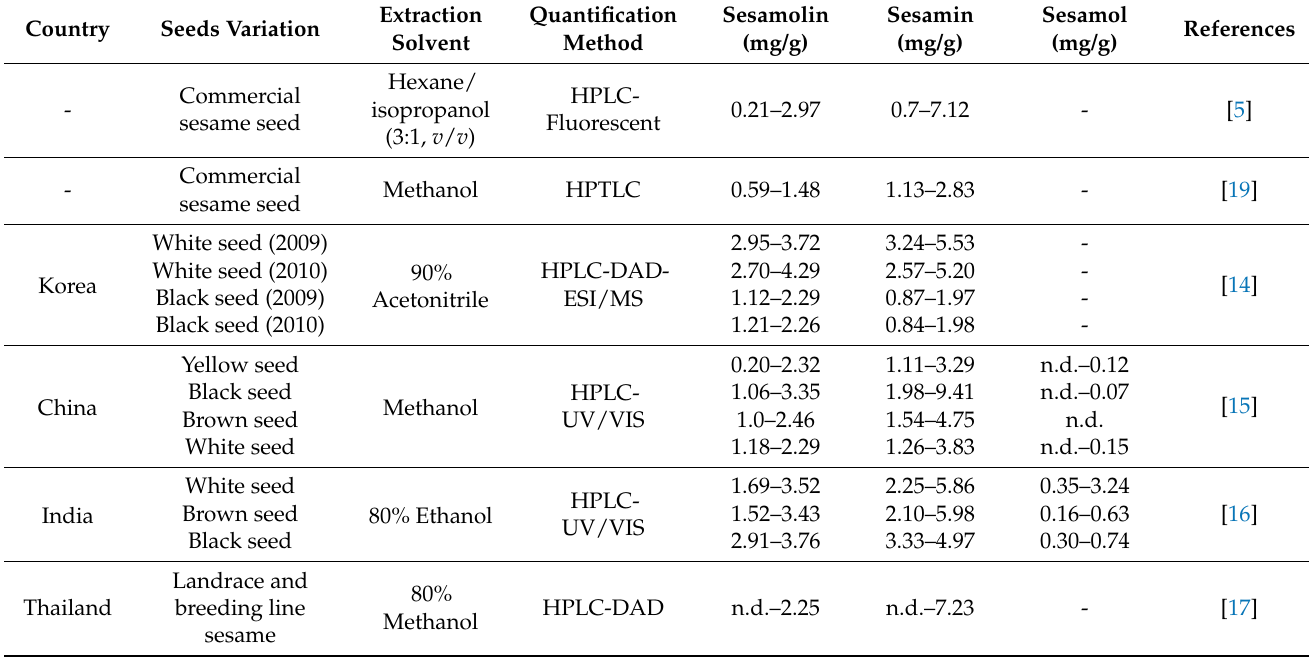
Table 1. Content of sesamolin in sesame